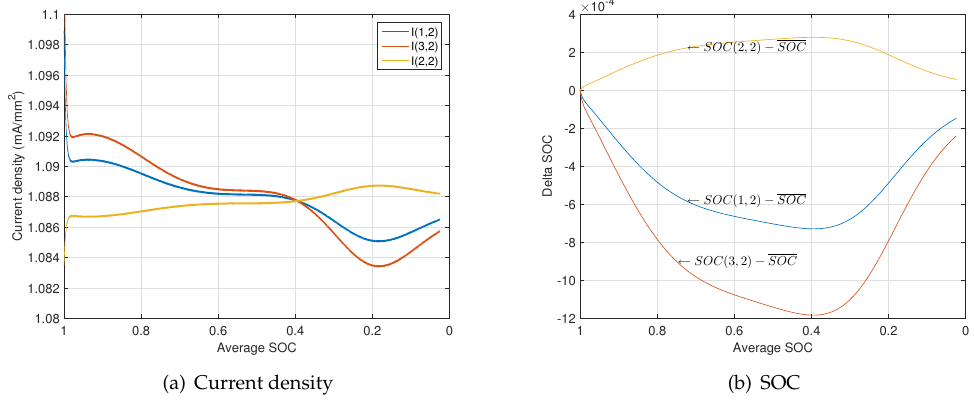
Figure 15. Non-uniformity evolution during discharge.